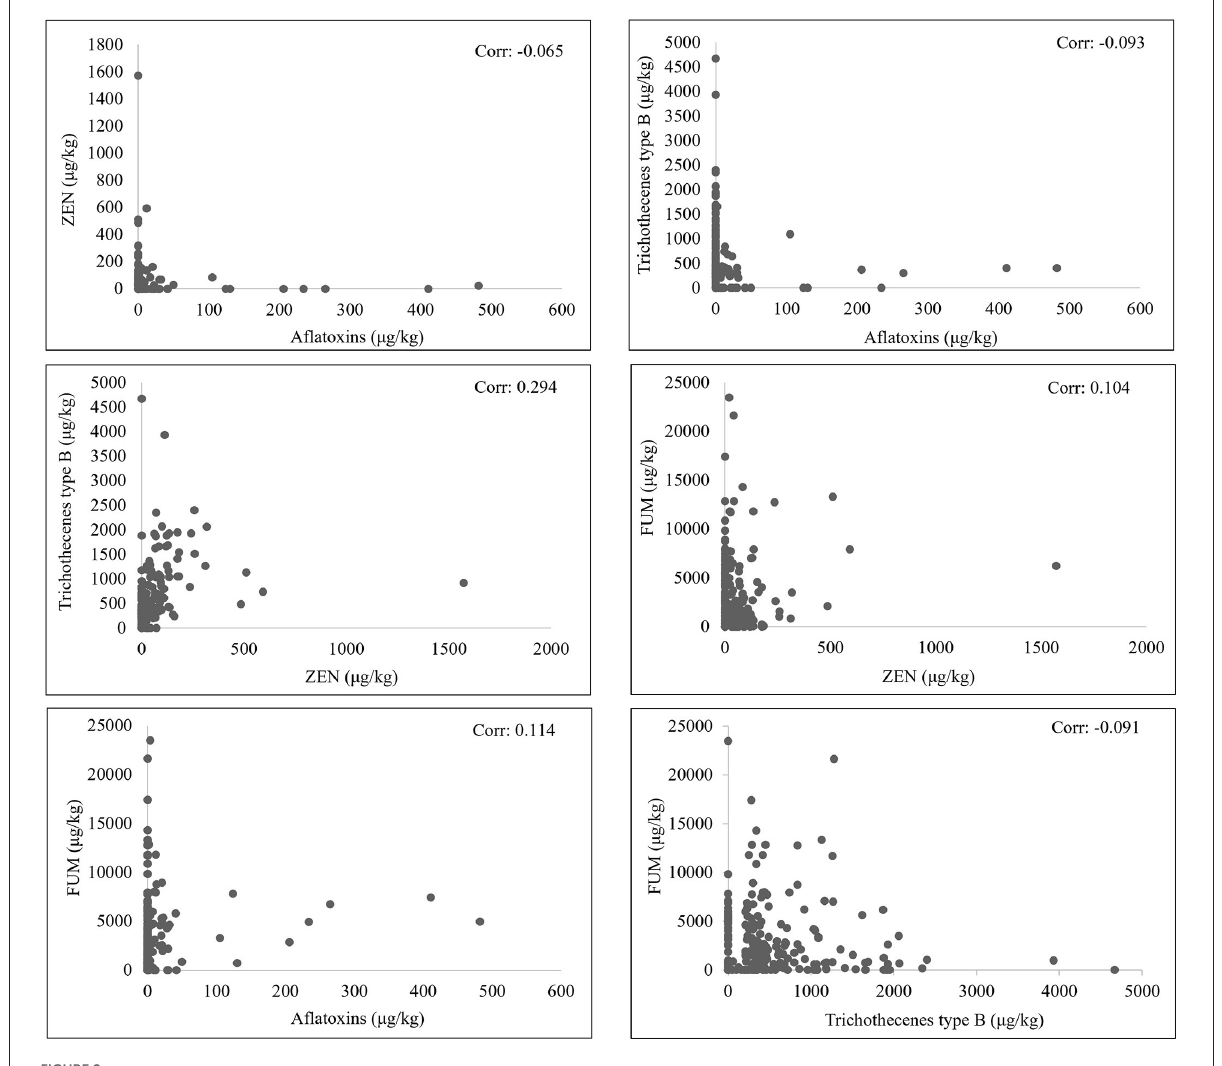
FIGURE2 Correlation of mycotoxin concentrations of new season